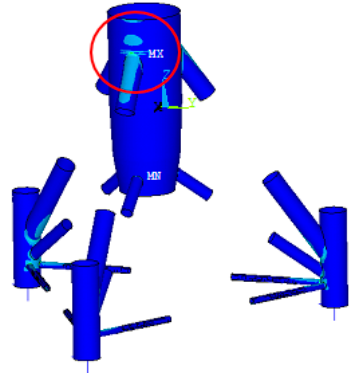
Figure 8. Location of maximum stress